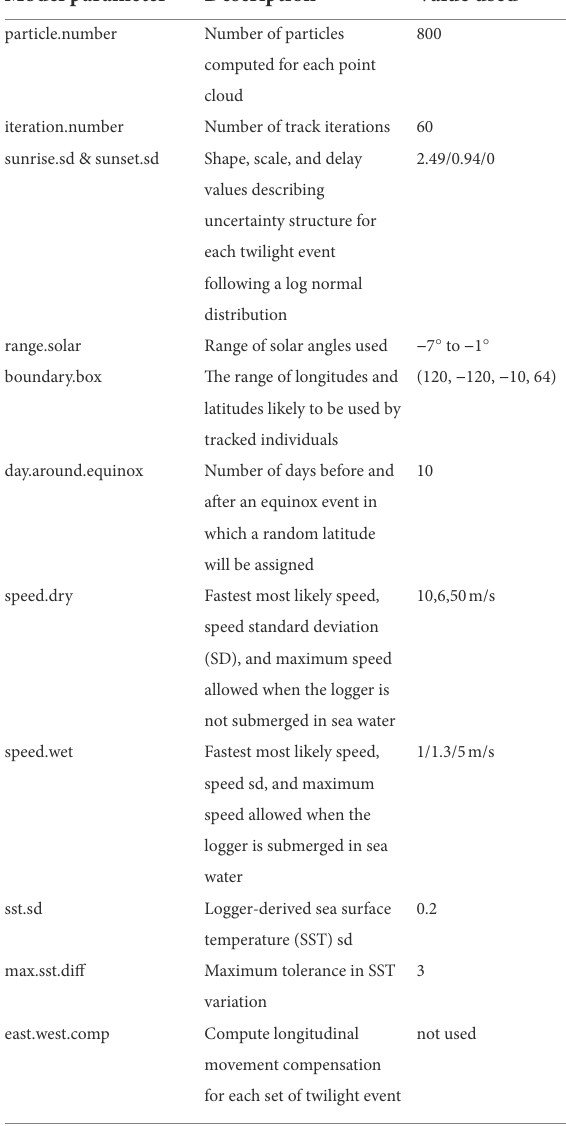
TABLE 2 “probGLS” algorithm parameters for estimation and analysis of positions using GLS data of black-footed albatross and Laysan albatross at Midway and